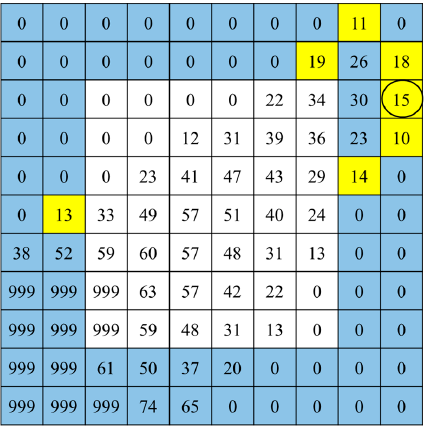
Figure 8. Touch point detection for Figure 6.